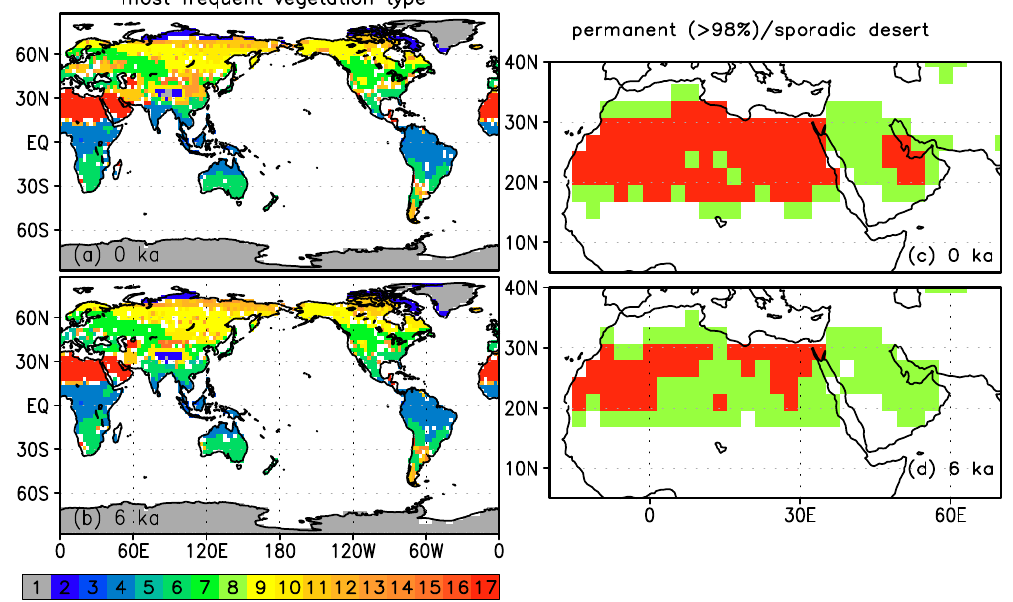
Fig. 10. Left panels: most frequent vegetation types in SEIB-DGVM with MIROC-ESM for 0 and 6ka. The grids with no stable vegetation type ( > 50%) are white. Numbers in the boxes at the bottom correspond to the vegetation types listed in Table 1. Right panels: desert areas shown in the left panels shaded in color for (c) 0ka and (d) 6ka. The red grids indicate permanent desert ( > 98%), whereas green grids indicate sporadic